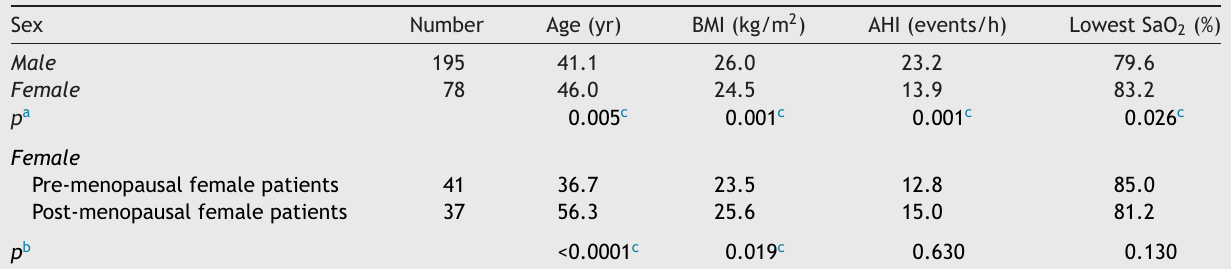
Demography and patient’s characteristics of PSG finding.